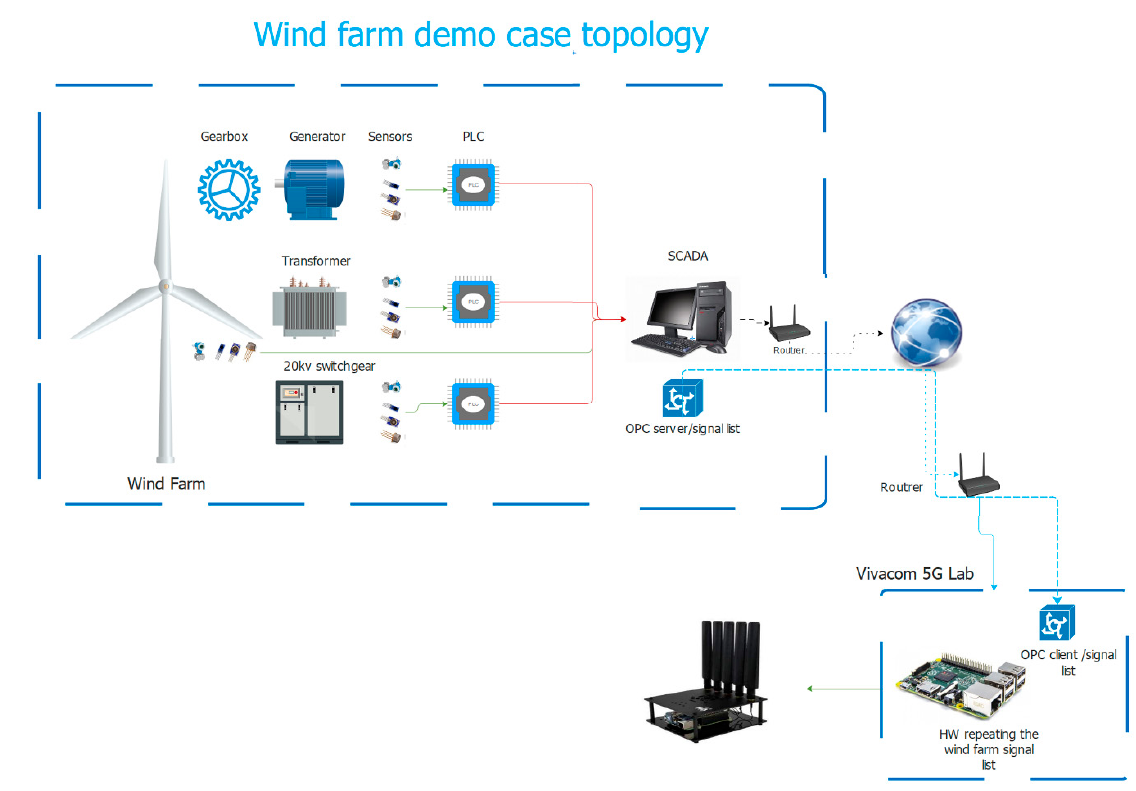
Figure 12. Site architecture of UC3.